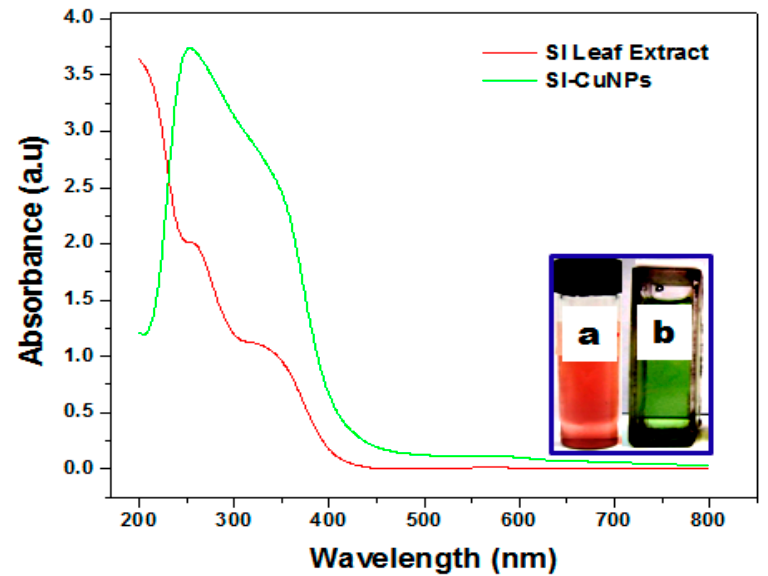
Figure 2. UV-vis spectra of SI leaf extract (red line) and Cu 2 O nanoparticles (green line). Visual picture of solution containing (a) SI leaf extract and (b) Cu 2 O nanoparticles.